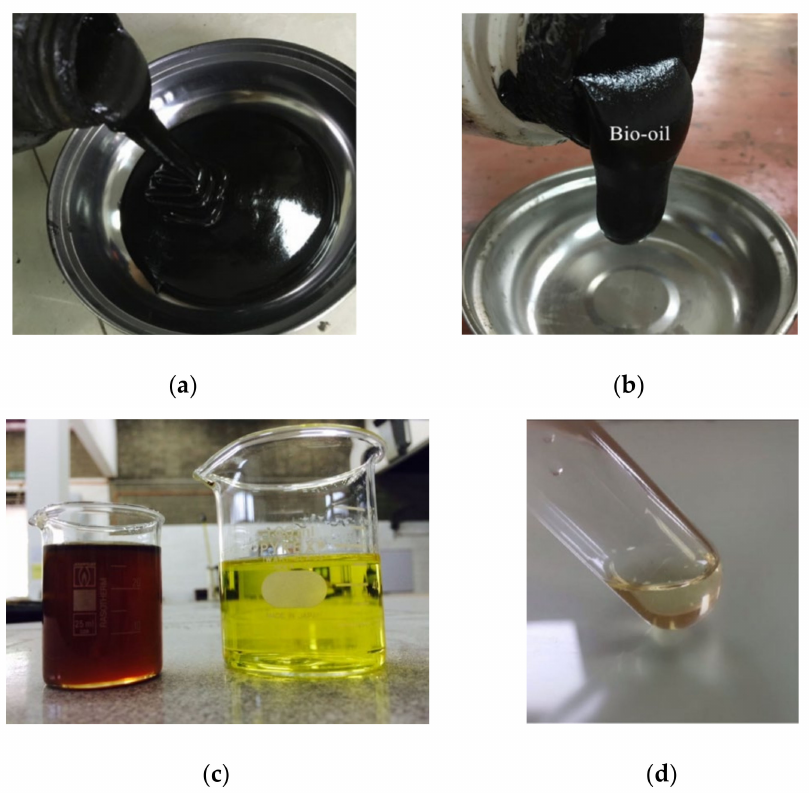
Figure 3. Bio-oils derived from various sources: ( a ) Waste wood [15]; ( b ) Corn stover [41]; ( c ) Waste cooking oil [42]; ( d ) Date seed oil